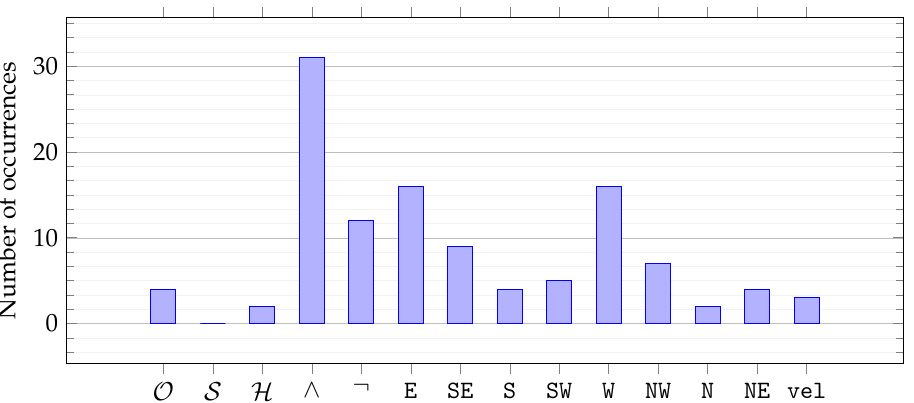
Figure 7. Number of occurrences of operators and attributes for the best individual of each evolu- tionary